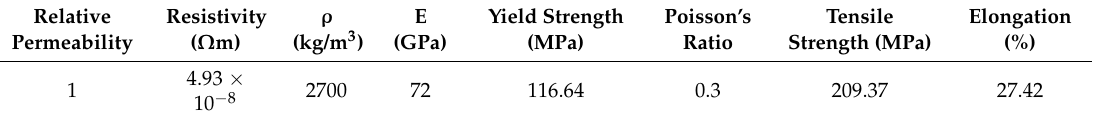
Table 6. Material parameters of the 5052-O aluminum alloy